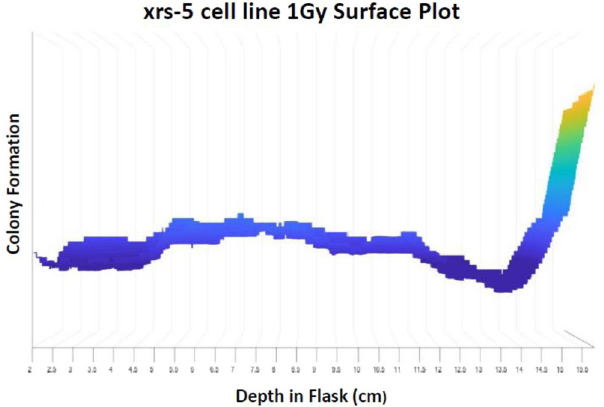
Figure 3. Colony formation vs depth of a radiosensitive cell line. The DNA double-strand break repair- defective cell line, xrs-5, demonstrates a dramatic decrease of colony formation from carbon-ion beam entry up to the biological Bragg peak depth.